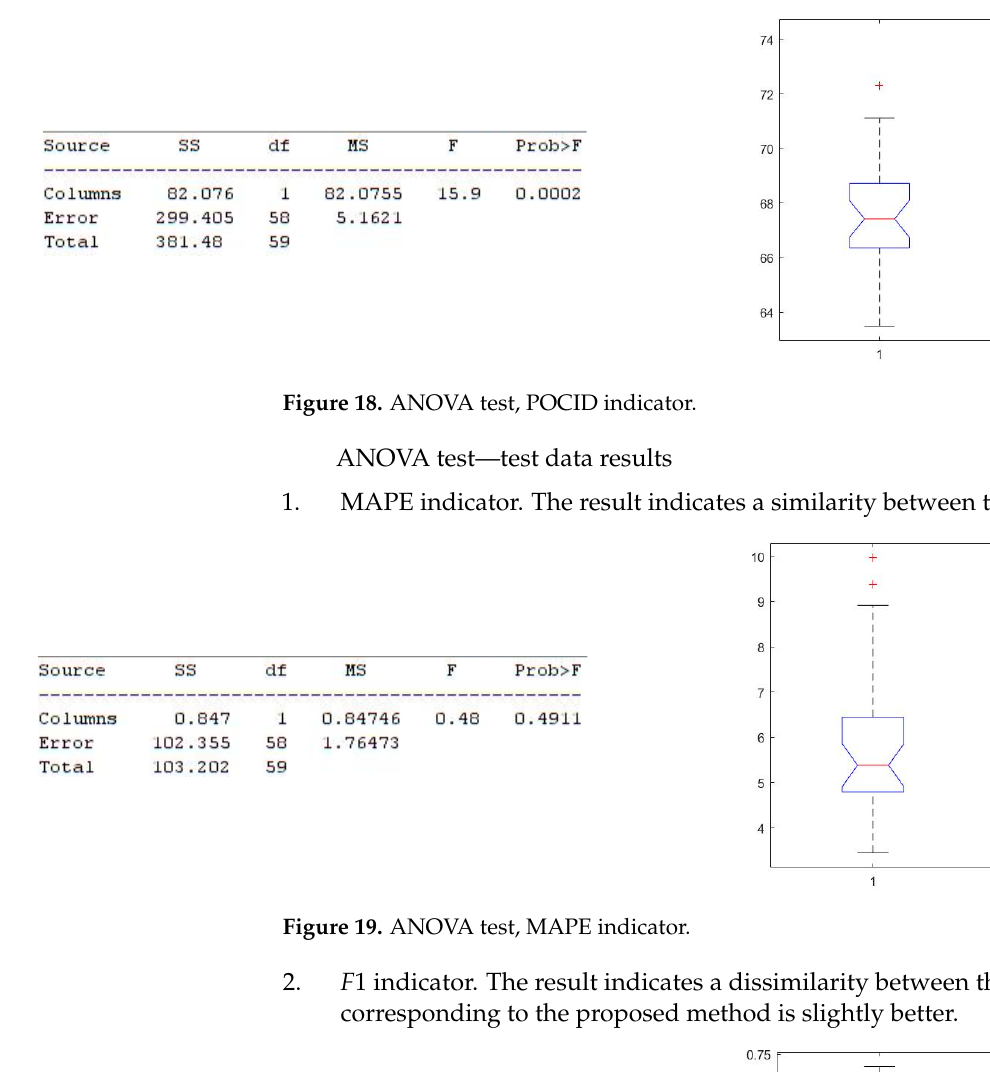
one corresponding to the proposed method being significantly better.